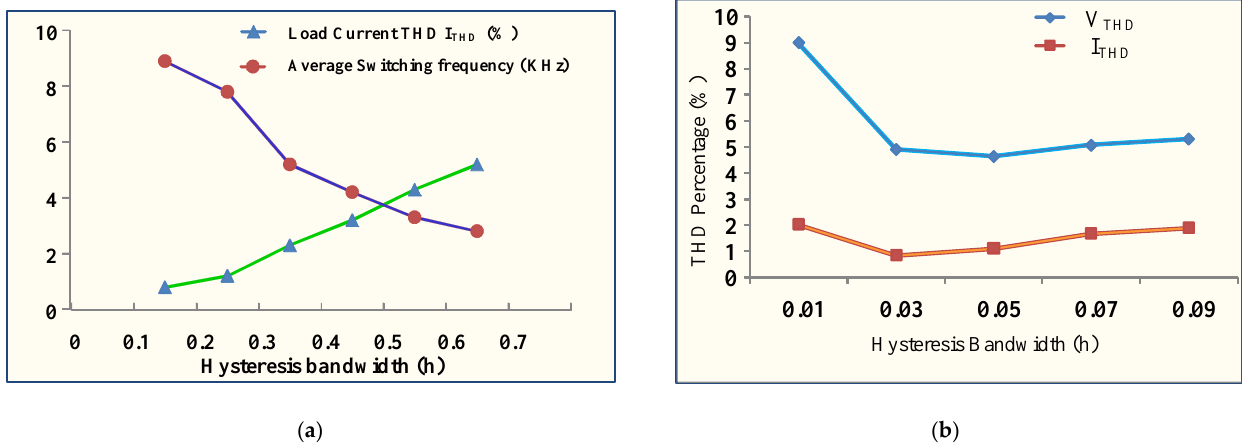
Figure 9. ( a ) Variation of load current THD and average switching frequency with hysteresis bandwidth ( h ). ( b ) Percentage THD variation in load voltage and current at different hysteresis bandwidth h .